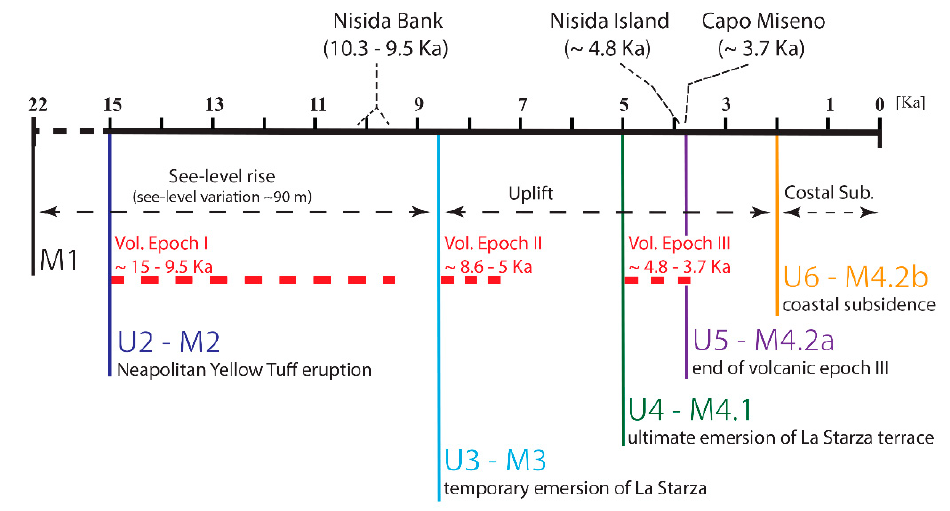
Figure 2. Sketch stratigraphic diagram showing the main regional unconformities (U2, U3, U4, U5, and U6) occurring in the Gulf of Pozzuoli, as controlled by the coastal subsidence, by the tectonic uplift, and by the sea level rise (modified after Steinmann et al., 2018) [34]. Ve I (Volcanic Epoch I–15-9.5 ky B.P.). Ve II (Volcanic Epoch II–8.6-5 ky B.P.). Ve III (Volcanic Epoch III–4.8-3.7 ky B.P.). M2, M3, and M4 (M4.1, M4.2a, and M4.2b) represent the seismic units of the Gulf of Pozzuoli. The seismic unit M2 corresponds to the caldera filling. The seismic units M3 and M4.1 correspond to the deposition in the uplifting resurgent dome. The seismic unit M4.2a represents an infralittoral prograding unit deposited between 3.7 ky B.P. and 2 ky B.P. The seismic unit M4.2b represents a coastal wedge deposited during and after the phase of volcano-tectonic subsidence starting at 2 ky